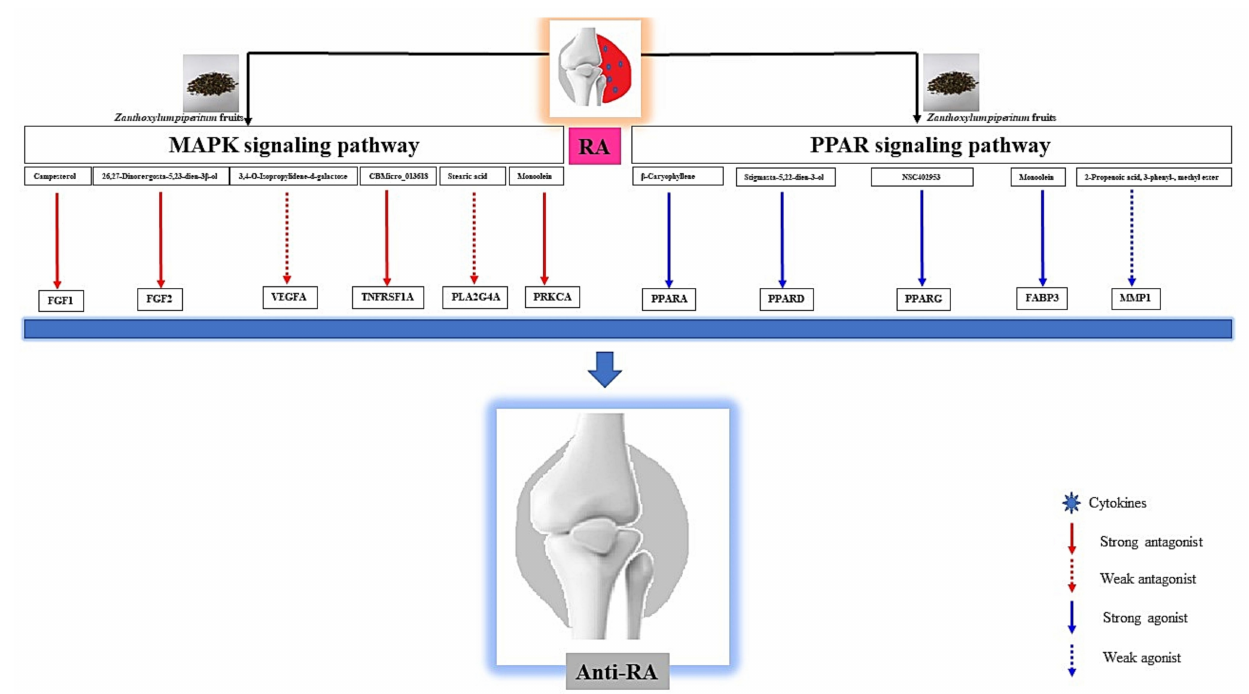
Figure 10. Schematic representation of key findings in the